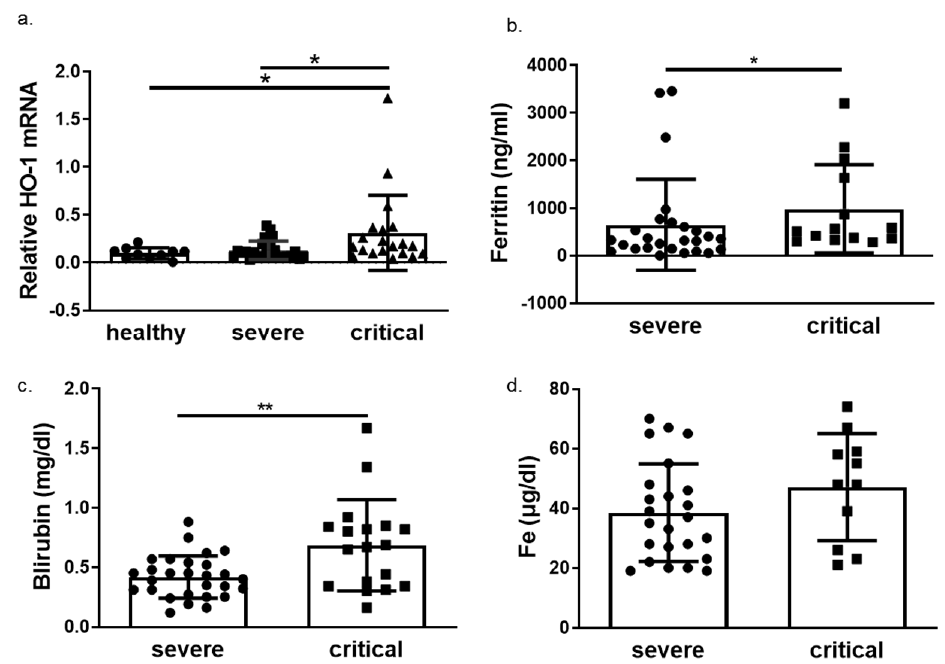
Figure 3. HO-1 is upregulated in critical COVID-19 patients with concomitant increase in ferritin and bilirubin. Whole blood samples were obtained on admission from patients with either severe or critical disease and processed directly. ( a ) HO-1 mRNA upregulation determined in critical patients versus severe and healthy controls from whole blood samples. Increase of ferritin ( b ), bilirubin ( c ) and iron levels ( d ) in critical versus severe COVID-19 patients. Data are expressed as means ± SD. Statistical analysis was performed by one-way ANOVA in three group comparisons and Mann– Whitney U test in two group comparisons. * p < 0.05, ** p < 0.01. Analysis of variance and post hoc analysis was performed by Uncorrected Fisher’s least significant difference test.